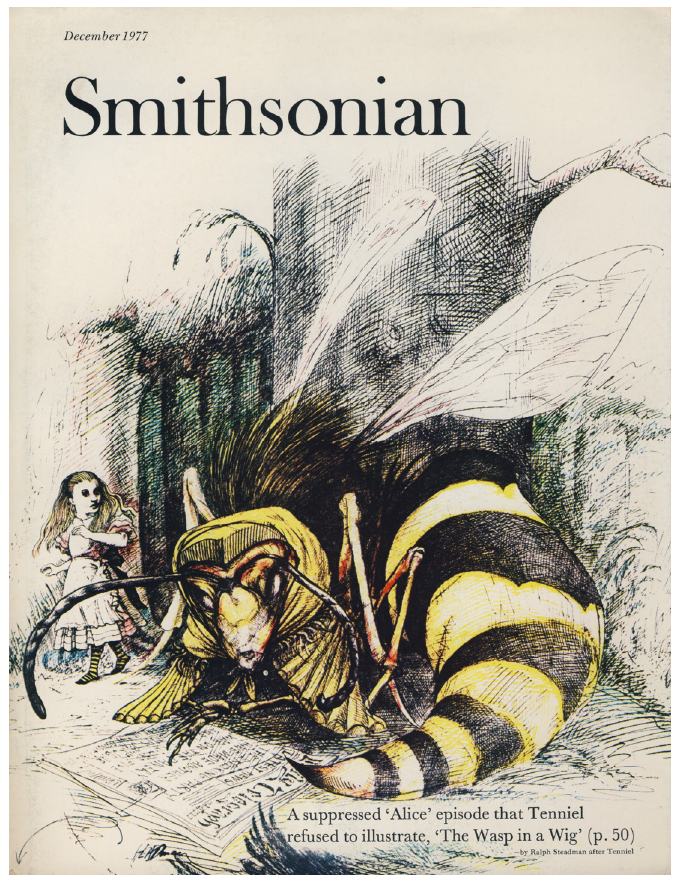
Figure 3. Ralph Steadman produced this cover illustration after John Tenniel, who refused to illustrate the Wasp in a Wig episode of Through the Looking-Glass and What Alice Found There . Smithsonian magazine printed the unpublished galleys and several attempts to visualize what Tenniel purported was “altogether beyond the appliances of art.” Cover illustration reproduced with permission from Ralph Steadman.